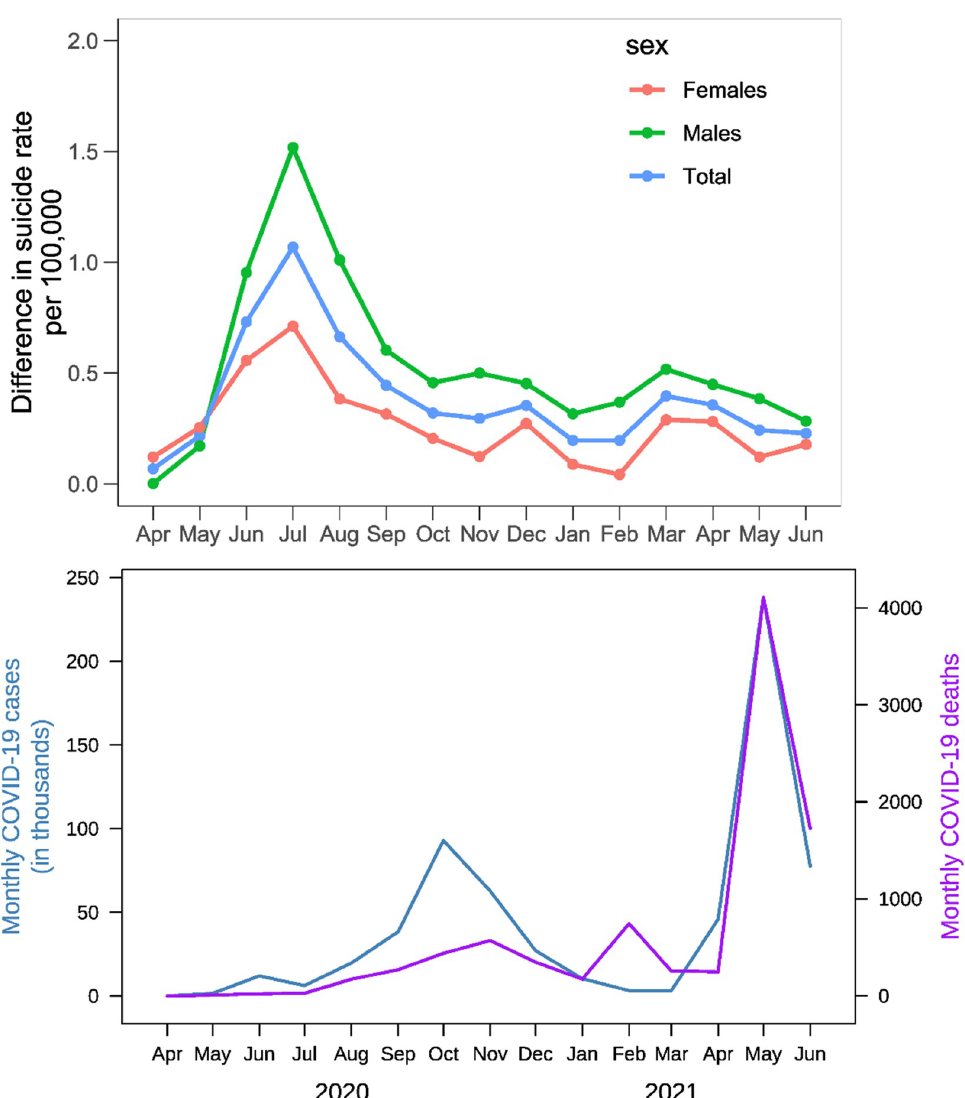
Fig 2. Unadjusted differences in monthly suicide rates in the pandemic months compared to the average rates of the same months in the immediate two pre-pandemic years (top panel) and monthly COVID-19 cases and deaths (bottom